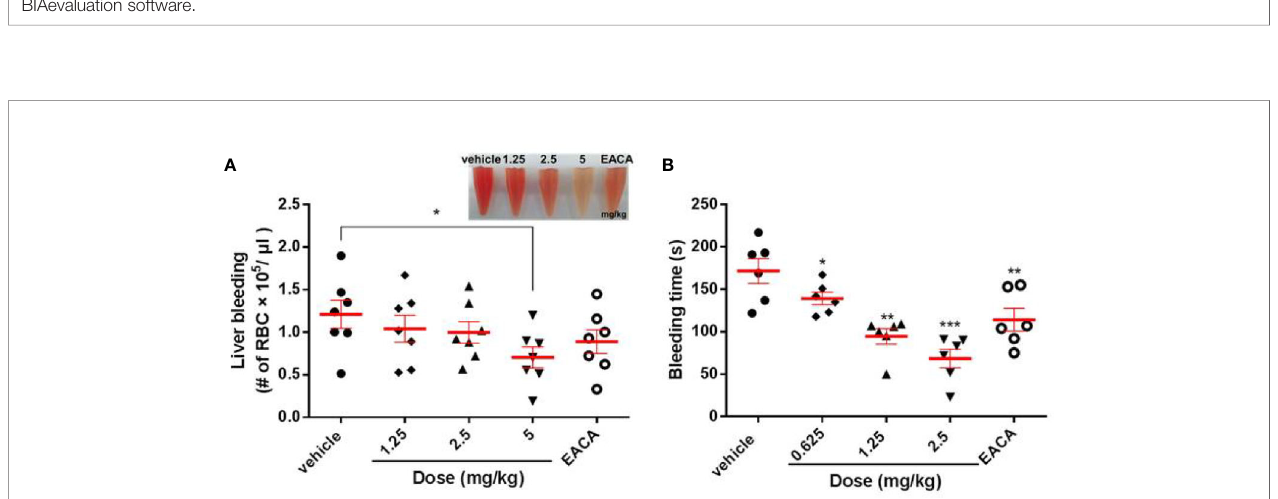
FIGURE 4 | Surface plasmon resonance (SPR) sensorgrams of interactions between LCTX-F2 and coagulation factors. The concentration of LCTX-F2 to FXIIa (A) , kallikrein (B) , thrombin (C) , and FXa (D) (from bottom to top) was 0, 3.125, 6.25, 12.5, 25, 50, and 100 m g/ml, respectively. Curves were analyzed with BIAevaluation software.